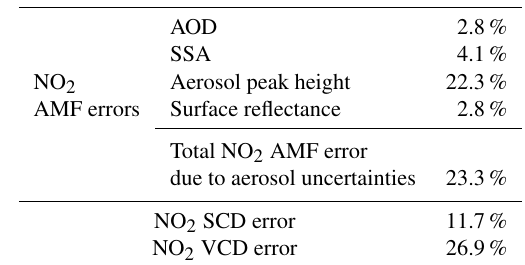
Table 6. Total NO 2 VCD caused by uncertainties in NO 2 SCD and NO 2 AMF (the average for the flight on 9 June